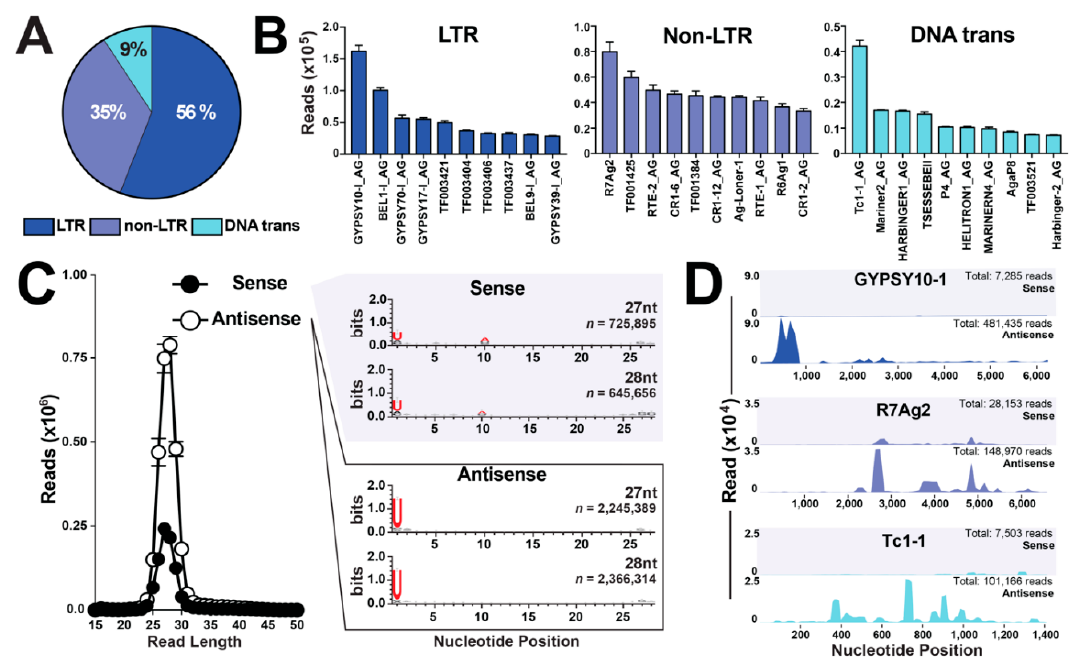
Figure 3. Sequence characteristics of TE-derived piRNAs in a mosquito ovary. ( A ) Percentage of piRNAs mapped to three classes of transposable elements: LTR, non-LTR, and DNA transposon. ( B ) Top ten piRNA mapping transposable elements for each class of transposable elements. Values graphed as the average +/ − SEM from three biological replicates. ( C ) Histogram of nucleotide size distribution of sense and antisense piRNA sequences. Values graphed as the average +/ − SEM from three biological replicates. WebLogo3 sequence bias analysis for 27- and 28-nt size sense and antisense piRNA sequences compiled from three biological replicates. ( D ) Mapping properties of sense and antisense piRNA reads compiled from three biological replicates mapped to the top LTR, non-LTR, and DNA transposon.